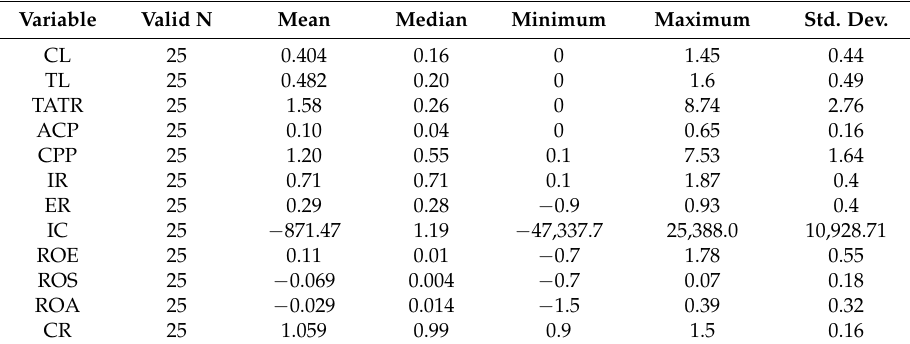
Table 4. Descriptive statistics for selected financial indicators.